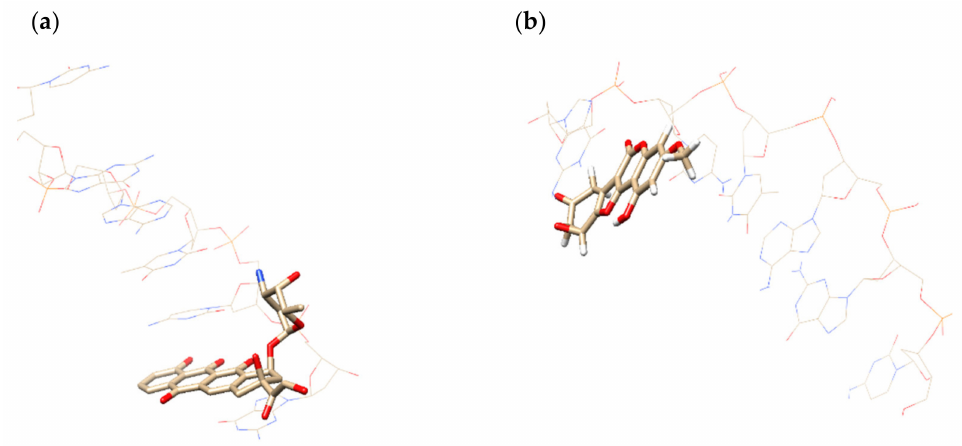
Figure 3. cDNA strand region—D (CGATCG) complexed to ligands: ( a ) experimental complex 1d37; ( b ) docked complex with DL.